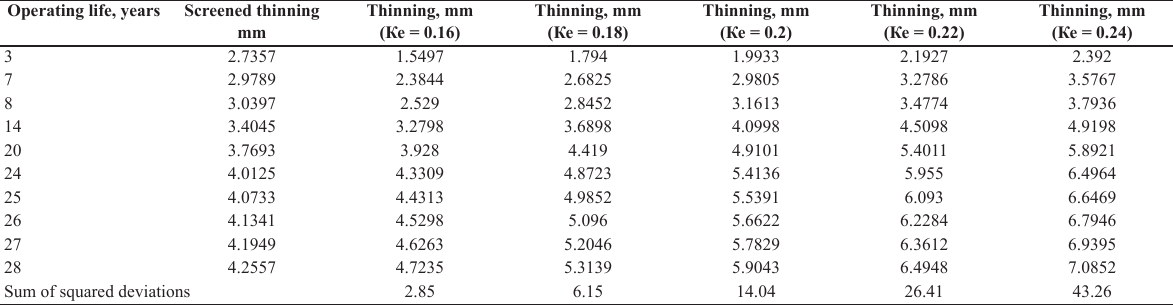
Table 5. Sums of the squared deviations for the shielded thinning and thinning at fixed values of the Keller coefficient. Operating life, years Screened thinning